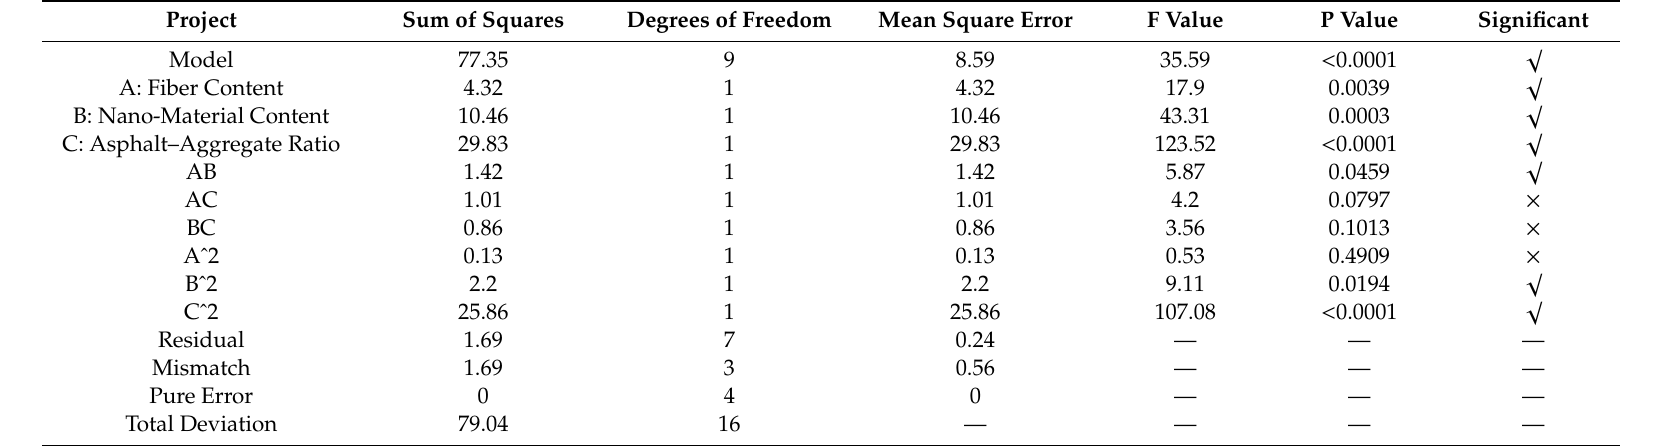
Table 15. Air voids variance test